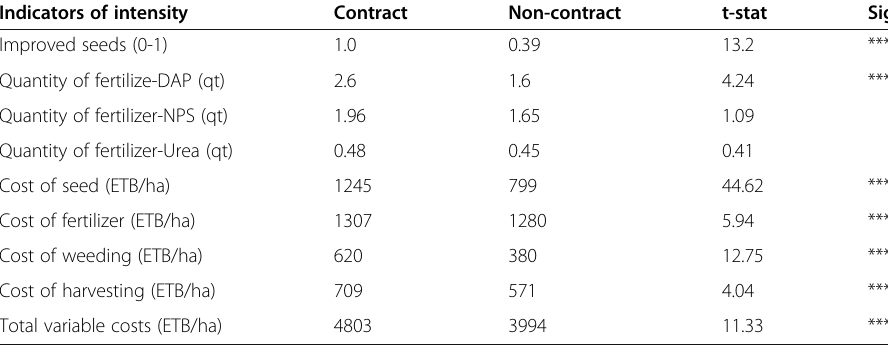
Table 5 Effect of CFA on intensification Indicators of intensity